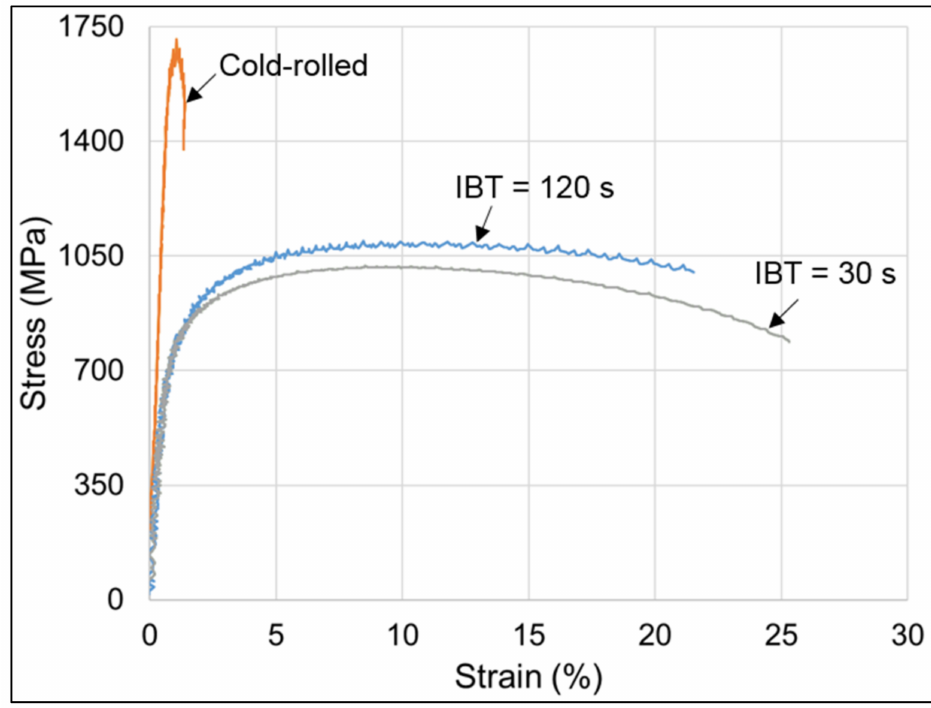
Figure 8. Stress vs. strain curves corresponding to the experimental steel. Mechanical properties of samples with IBT times of 30 s and 120 s were used for